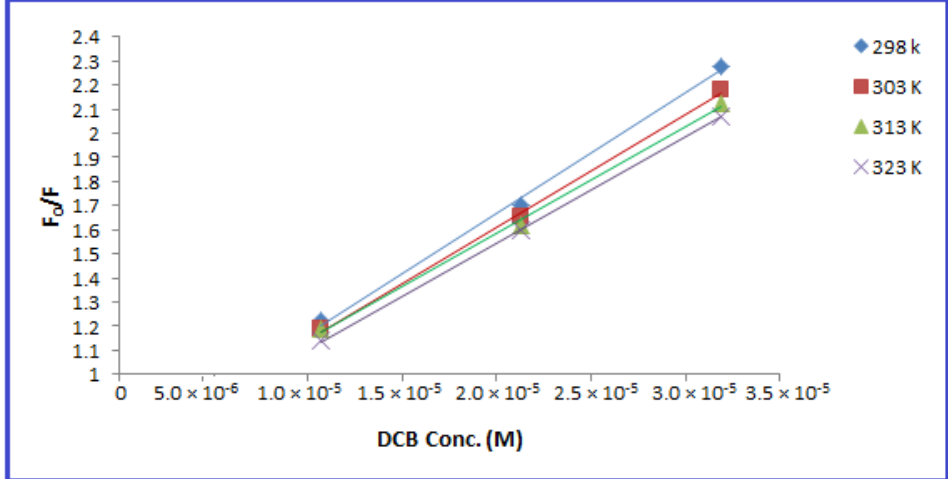
Figure 3. Fluorescence emission spectra of N-CQDs upon the addition of different concentrations of Figure 4. Stern–Volmer plots for the quenching of N-CQD fluorescence by DCB at four different DCB (from top to bottom: 0, 1.0, 2.0, 4.0, 8.0, 12.0, 14.0, 16.0; 20.0 µg/mL). temperature settings (298, 303, 313, and 323 K).